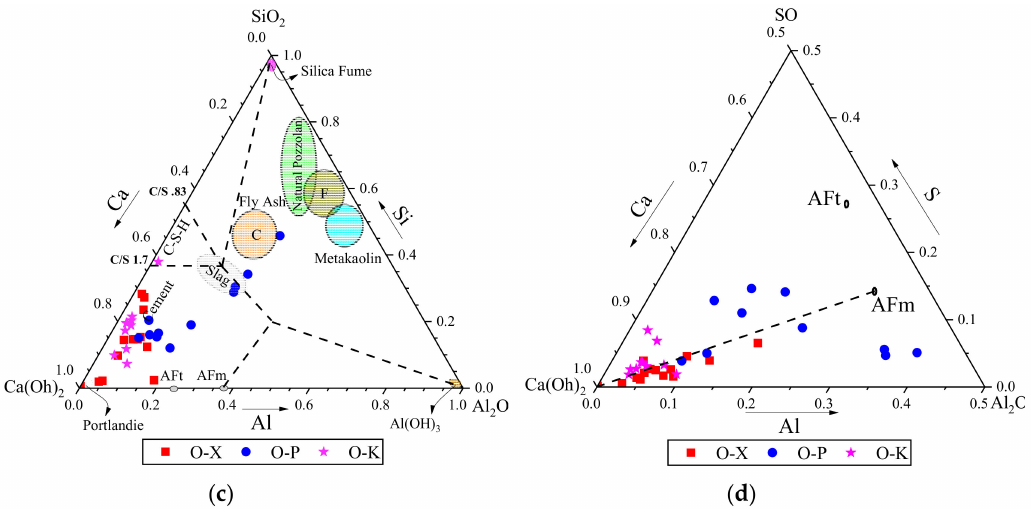
Figure 8. Di ff erent CWA treated cementitious composites: atomic ratio plot of ( a ) Si / Ca vs. Al / Ca, ( b ) Al / Ca vs. S / Ca; and ternary diagrams of ( c ) Ca-Si-Al, ( d )